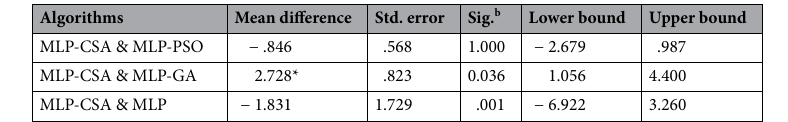
Algorithms Mean difference Std. error Sig. b Lower bound Upper